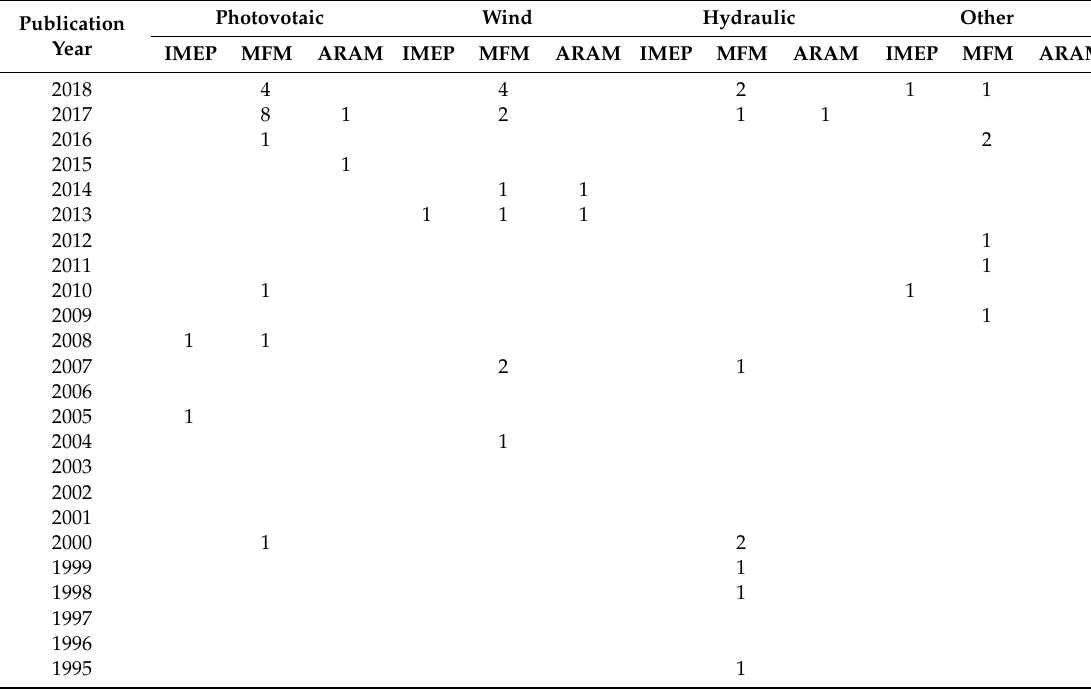
Table 7. ANN tendency by Renewal Energy